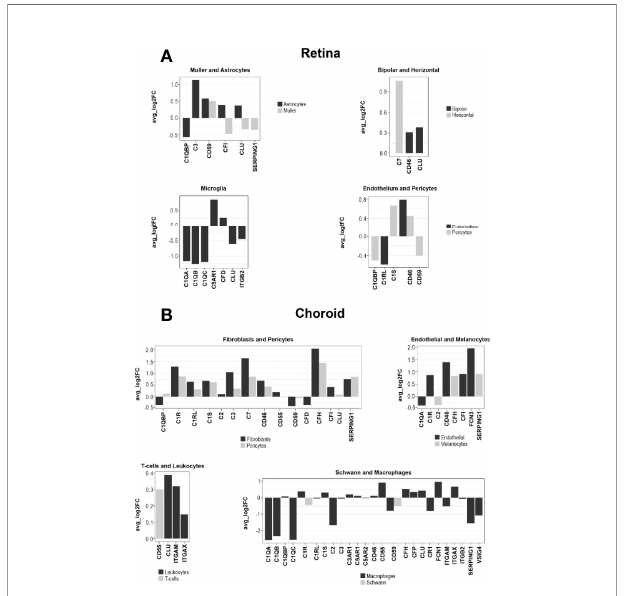
FIGURE 8 | Log fold change (FC) of complement gene transcription within retina and choroidal cells from donors diagnosed with early AMD. (A) LogFC of Differentially expressed (DE) retinal genes between early AMD macula and normal macula were de fi ned as a gene showing expression in at least 10% of cells within a cell type and a P ≤ 0.05. (B) LogFC of DE choroidal genes between early AMD macula and normal macula were de fi ned as in